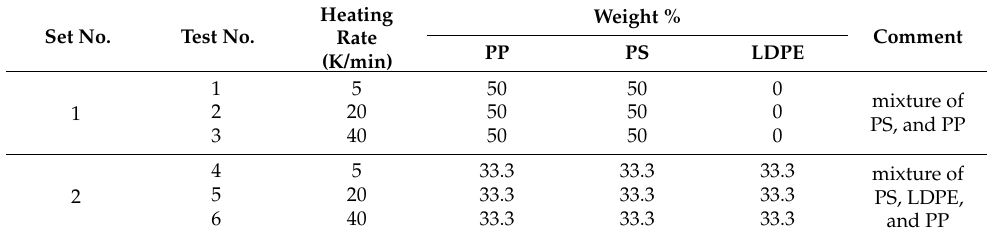
Table 2. List of six runs of different PS, LDPE, and PP polymers compositions. Set